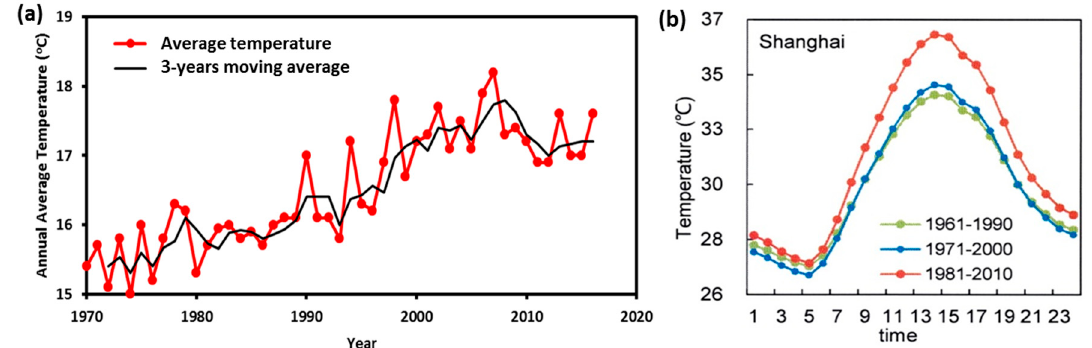
Figure 4. Impact of climate change in the city of Shanghai ( a ) annual average temperature change [32] (Presented temperatures are the annual average temperatures for the entire year) and ( b ) hourly temperature variation in summer for different periods [34].